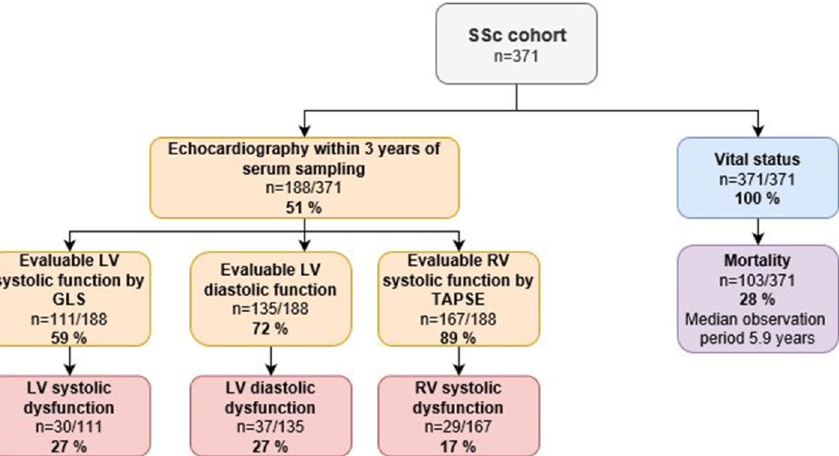
Figure 2. Flow chart on cardiac function and vital status of the SSc cohort. GLS global longitudinal strain, LV left ventricular, RV right ventricular, SSc systemic sclerosis, TAPSE tricuspid annular plane systolic excursion.